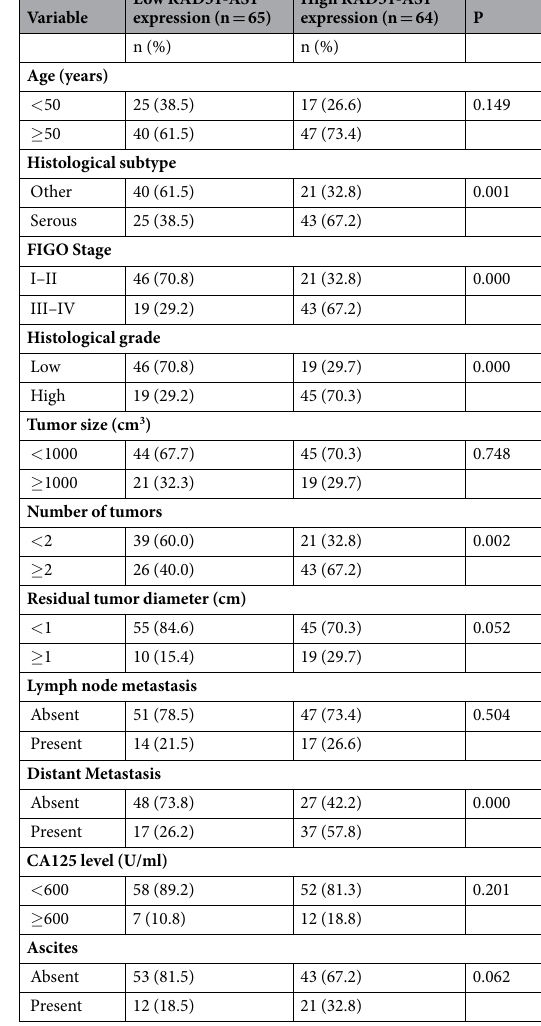
Table 1. Association of RAD51-AS1 expression with clinicopathological features of EOC patients. NOTE: The median value of RAD51-AS1 expression was used as a cut-off for the low/high RAD51-AS1 expression groups. Data were analyzed using the χ 2 test. All tests were two-sided, and P < 0.05 was considered